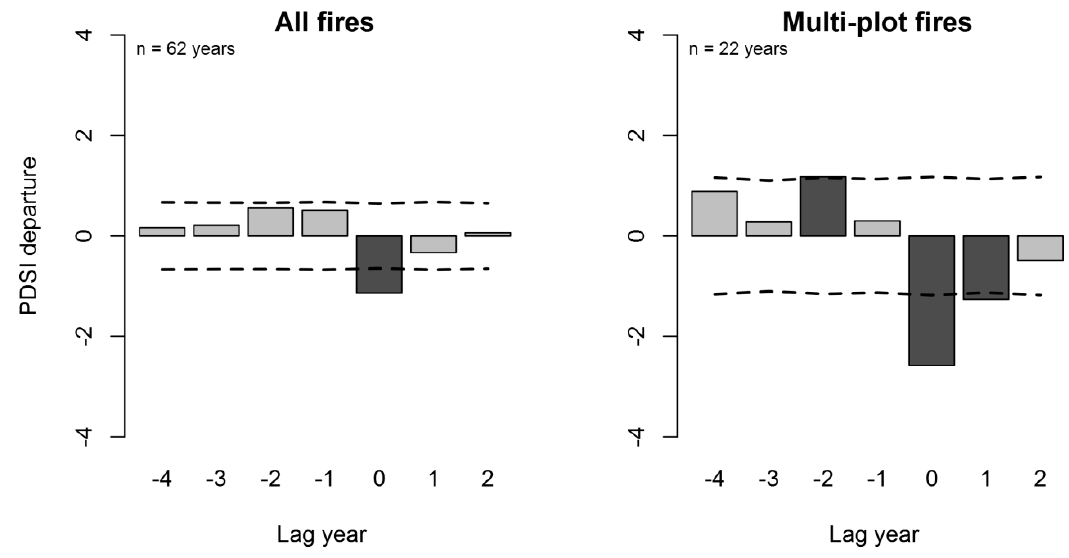
Figure 6. A superposed epoch fire–climate analysis of all fires (left) and multi-plot fires (right) in the Taos Valley Watersheds (1600–1899). Fires were associated with drought ( − PDSI (Palmer drought severity index)) during the fire year, preceded by wet years (+PDSI). An increased drought severity was associated with multi-plot fires. The dashed lines indicate the 95% confidence intervals derived from 1000 Monte Carlo simulations, and the black bars highlight significant departures from mean PDSI.